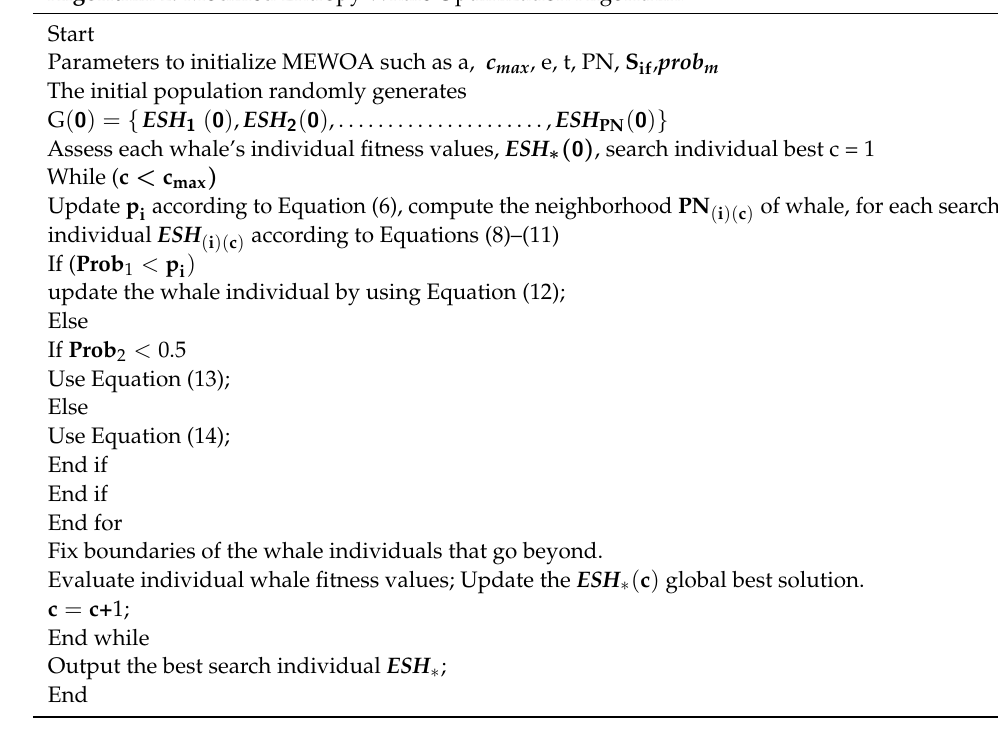
Algorithm 2: Modified Entropy Whale Optimization